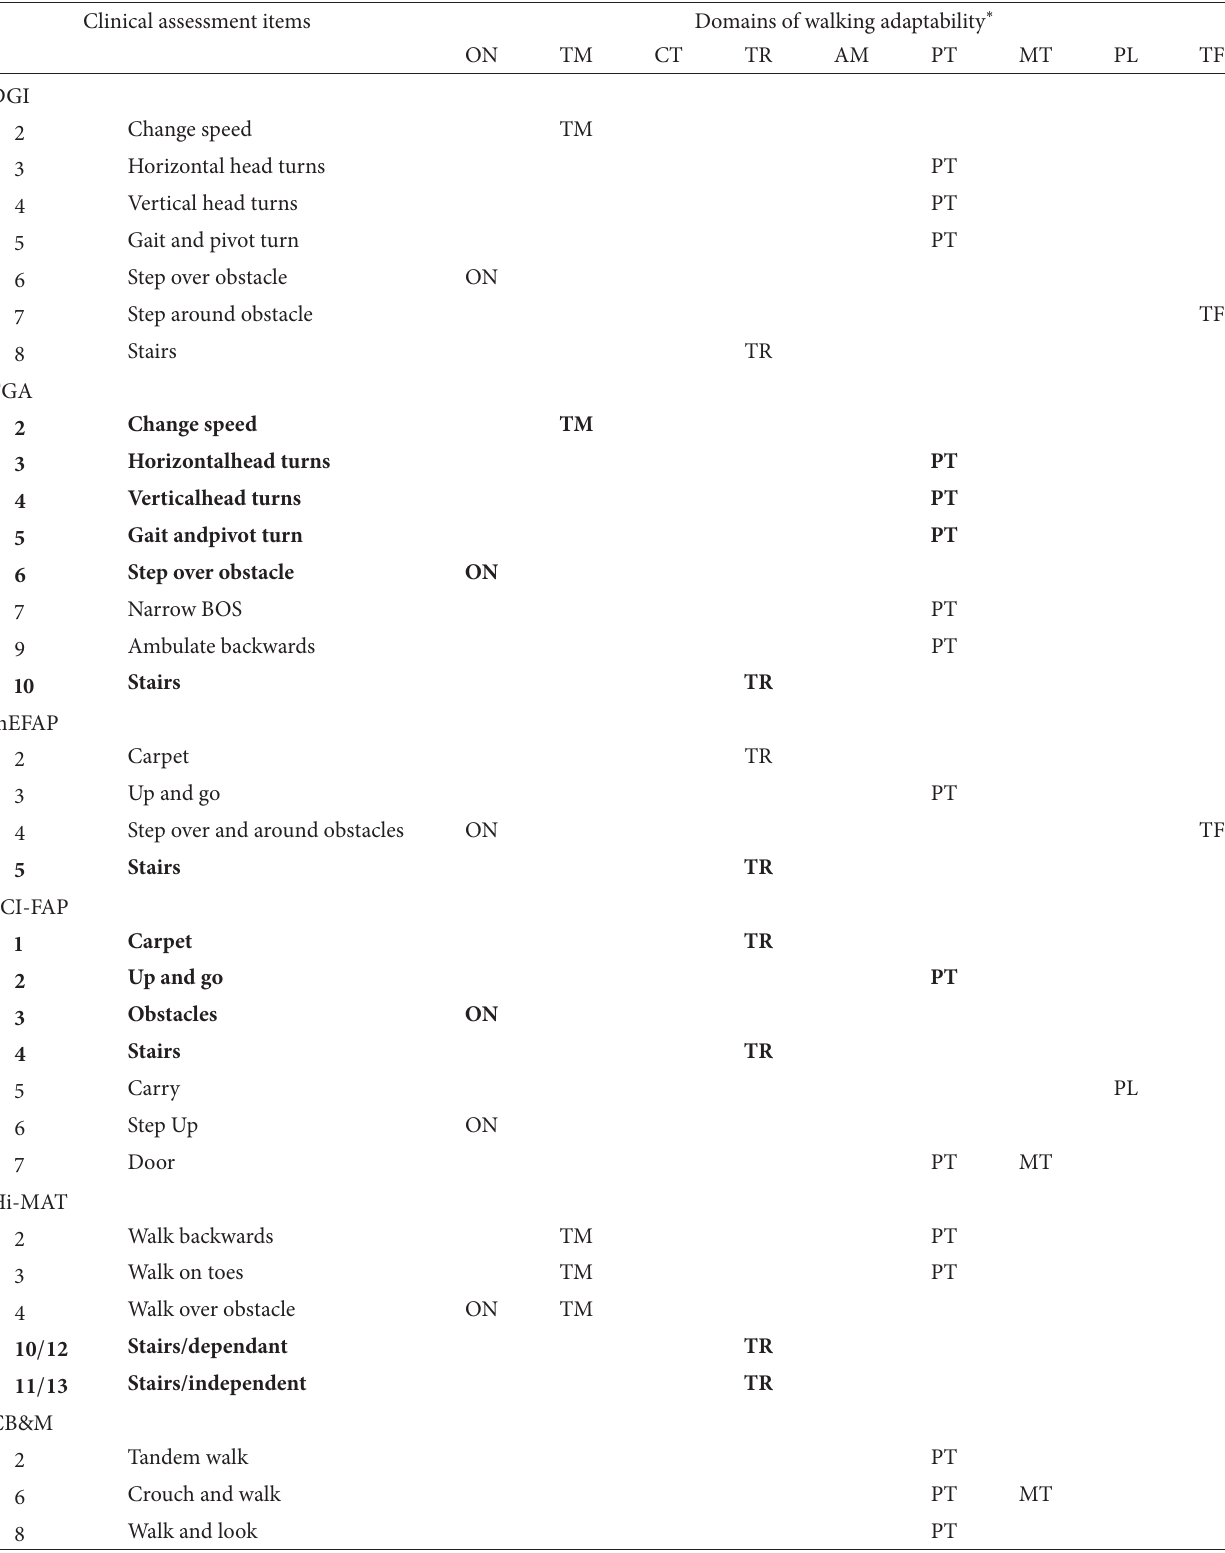
Table 3: Domains of walking adaptability captured by performance-based clinical assessments of walking function. Clinical assessment